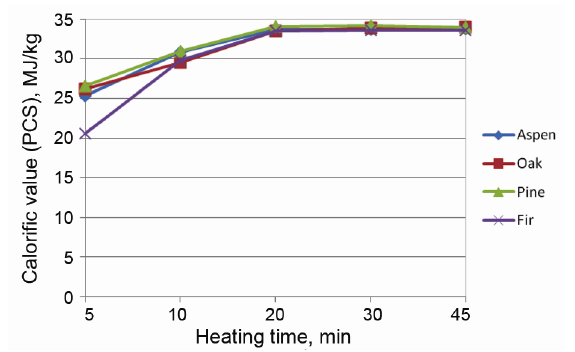
Fig. 13. Average dependency of calorific value of char resulting